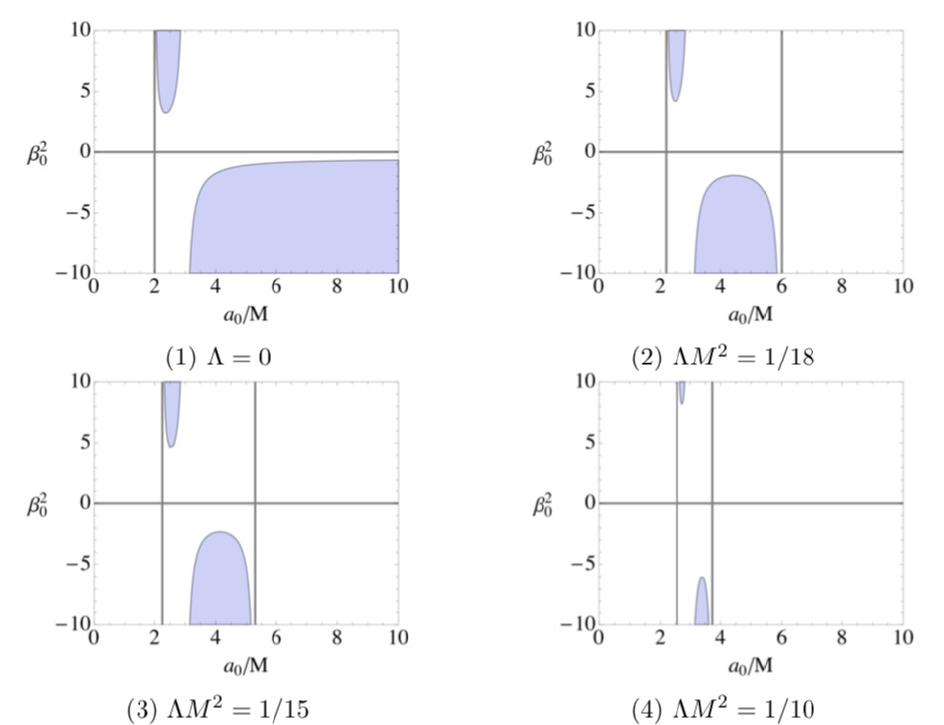
Figure 10. Schwarzschild–de Sitter thin-shell wormholes. The shaded regions indicate stable ones. In Figures 2–4, the right-side vertical lines correspond to the cosmological